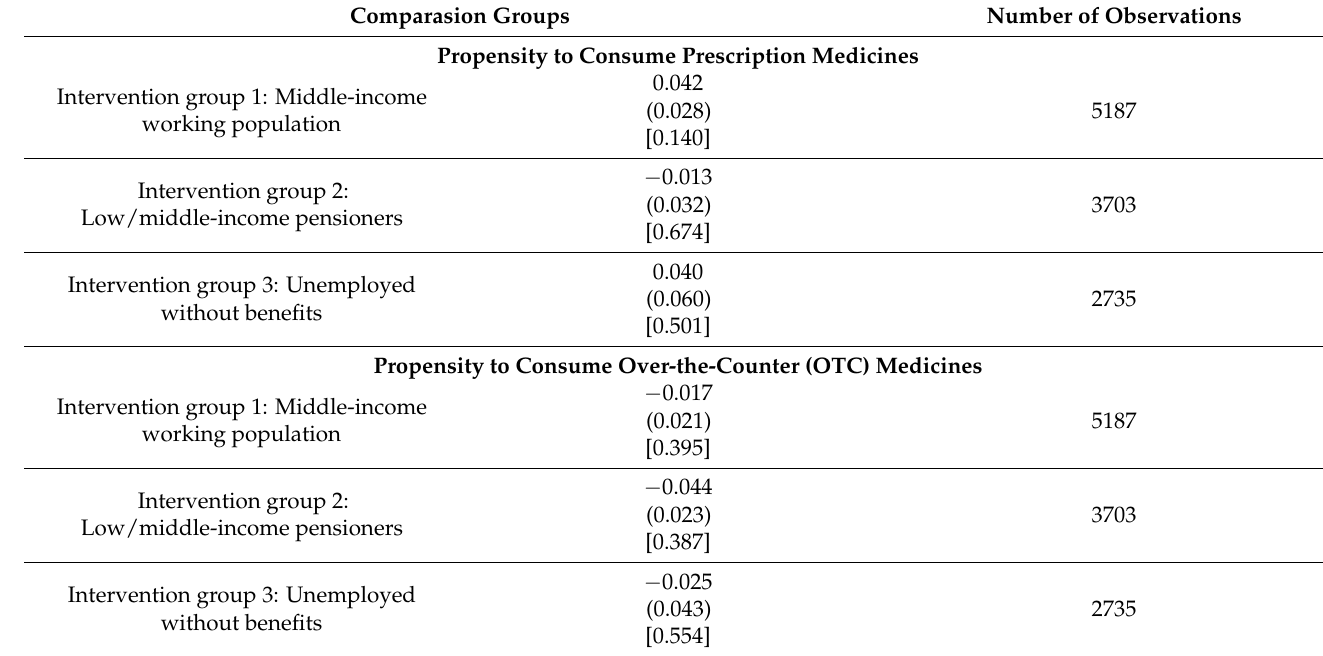
Table 3. Test of common trends assumption using differences-in-differences estimates.